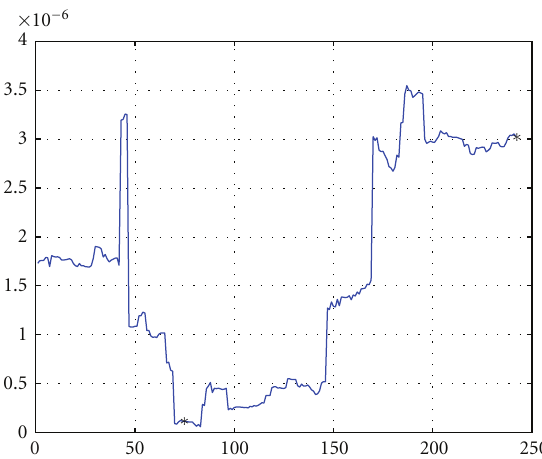
Figure 2: Coe ffi cient of 4th-order of the potential associated with the pdf computed using 100-years sliding windows. The larger the value the broader the pdf. The “ ∗ ” mark is the periods P1 and P2 used in the study, which have di ff erent pdfs reflecting di ff erent modes of behavior of internal variability in the south American climate.